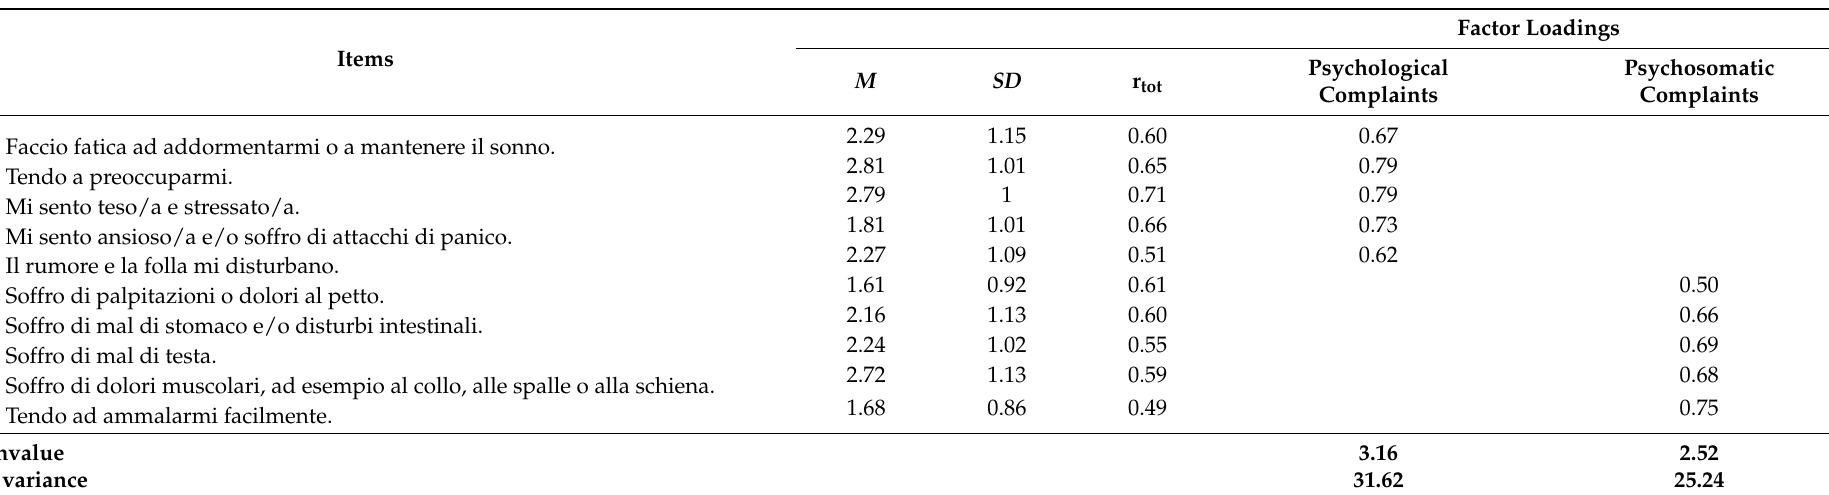
Table 3. Exploratory factor analysis results of the BAT Secondary Symptoms